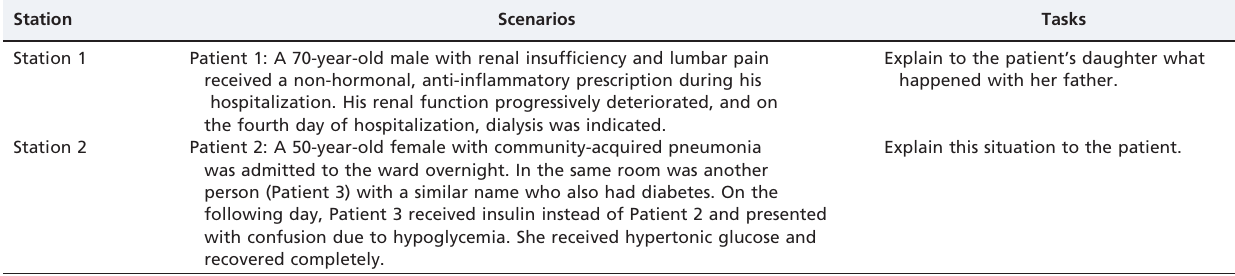
Table 1 - Patient safety stations: scenarios and